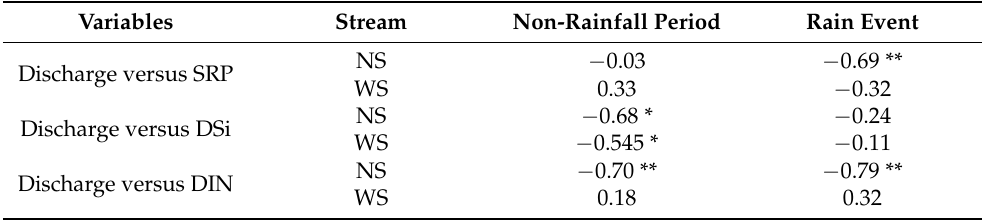
Table 2. Kendall’s correlation coefficients between river discharge and nutrient concentrations during the non-rainfall period and rain event in the NS and WS of the